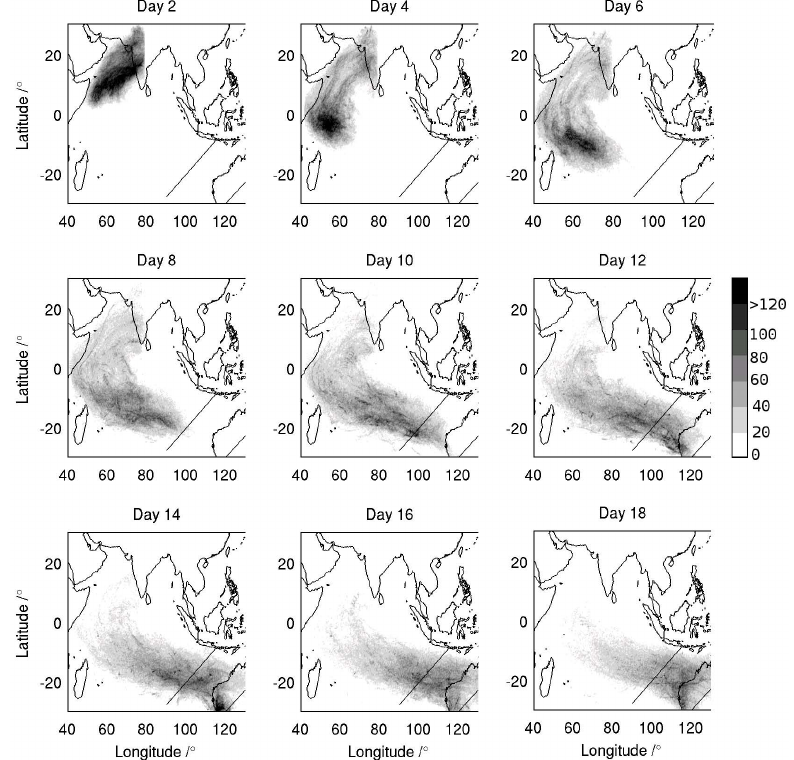
Fig. 2. Shading shows the number density of air parcels at a particular timestep, or the number of air parcels on a 0 . 25 ◦ × 0 . 25 ◦ resolution grid. Only air parcels of back-trajectories from India that reach Australia and precipitate first in the West India domain are shown. Lines demarcate boundaries of the evaporative region in the tropical east Indian Ocean and of interior Australia. Parcels are removed when they cross the Australian